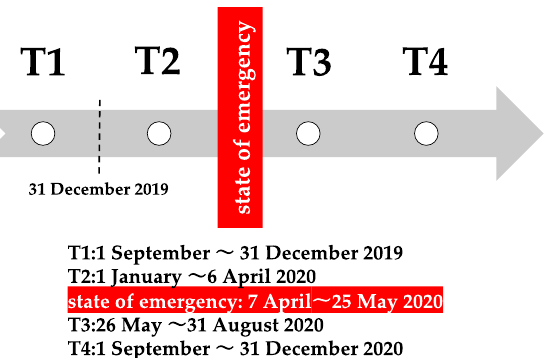
Figure 1. Timeline for the periods of analysis. On 31 December 2019, an outbreak of a novel coronavirus was reported. To evaluate the effect of the pandemic, the following four-time points were evaluated: T1, T2, T3, and T4.